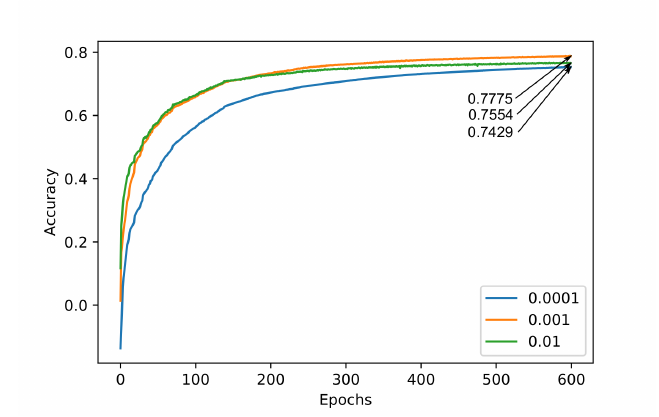
Figure 3. Learning rate selection.